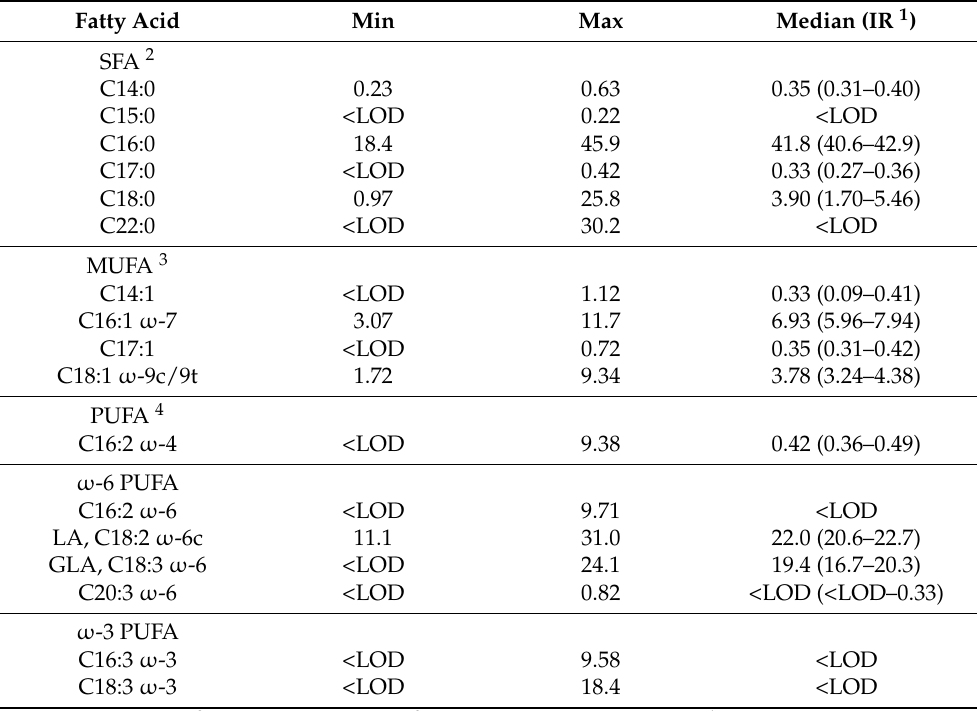
Table 7. Fatty acid content (% of total fatty acid content) in Spirulina supplements. Fatty